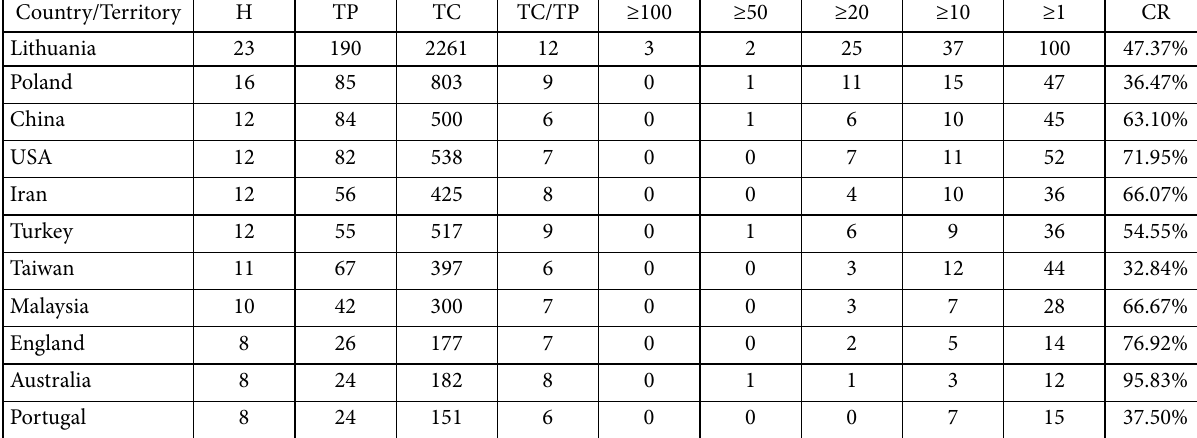
Table 4. TOP H-index